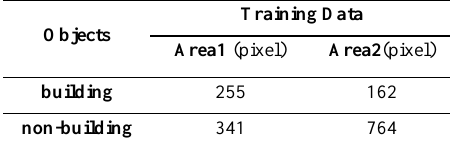
Table 1: The number of training data for each area